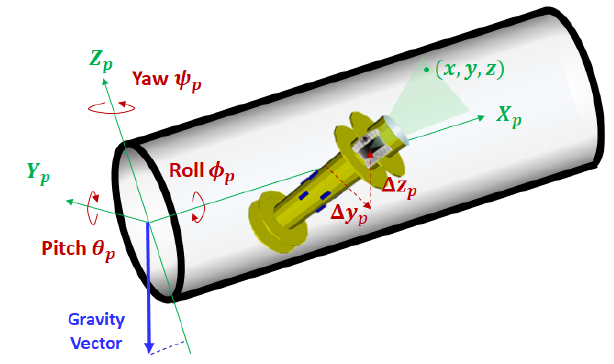
Figure 4. Navigation pipe